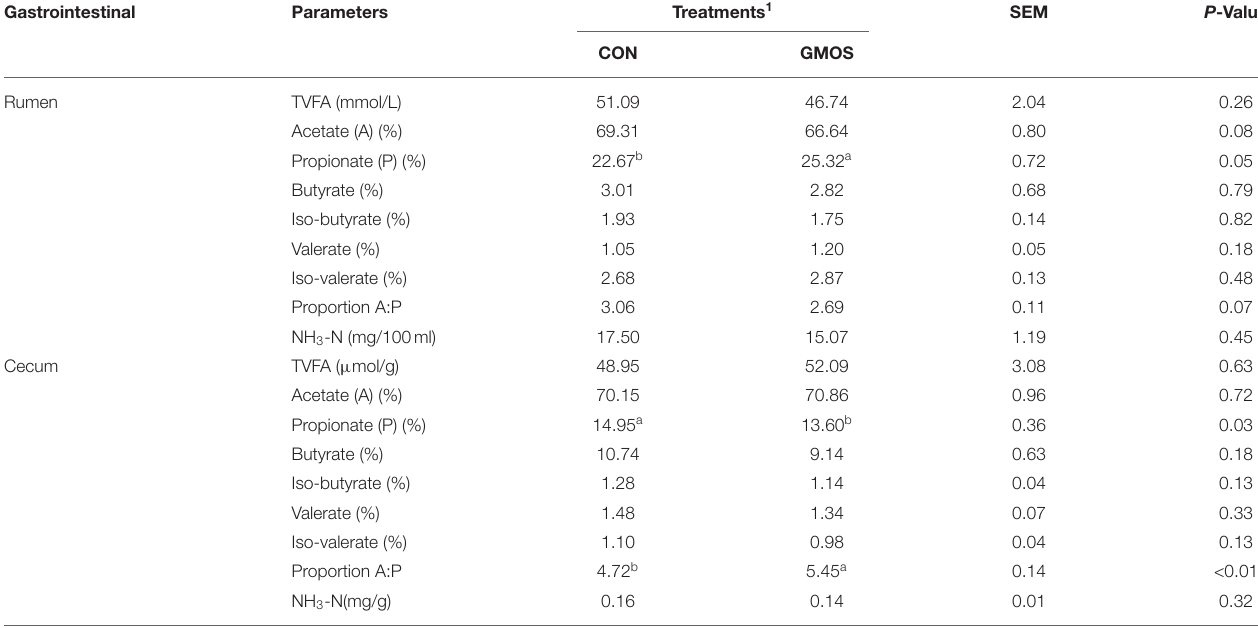
TABLE 4 | Effects of dietary supplementation of GMOS on ruminal and cecal fermentation parameters in goats.